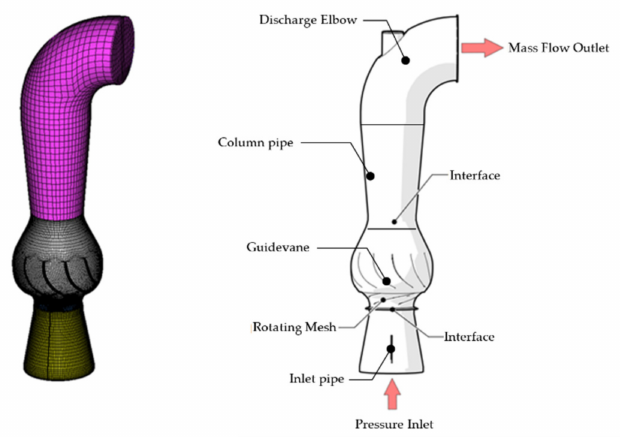
Figure 1. ( a ) The active components for the KSP-CV: 5-blade rotating impeller and 12-blade stationary guidevane/diffuser. ( b ) The generated hexahedral mesh used for the numerical analysis. ( c ) Impeller and guidevane blade walls.